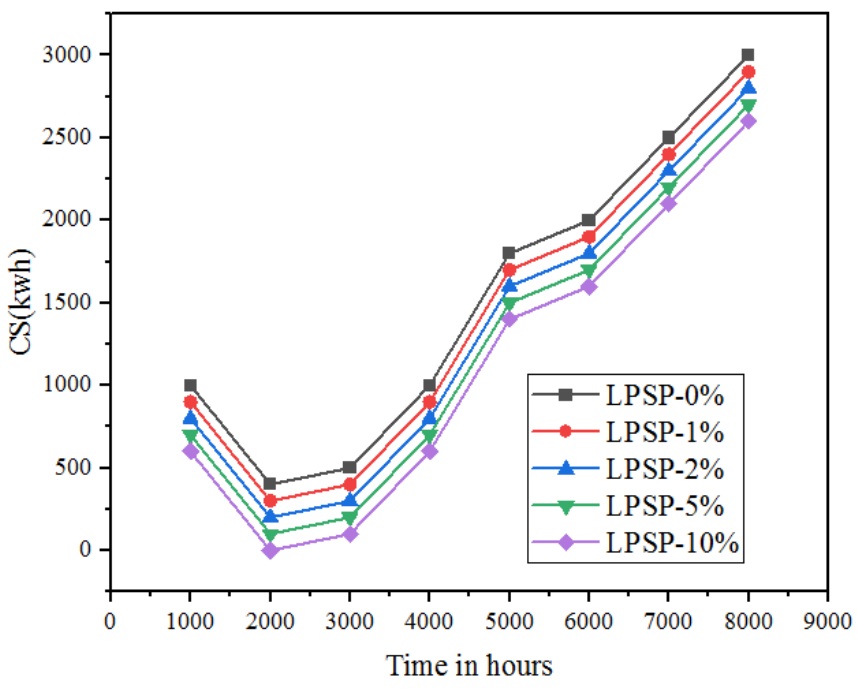
Figure 4. The comparative result of an optimized hybrid ROD system/battery/solar to various loss of power supply probability.